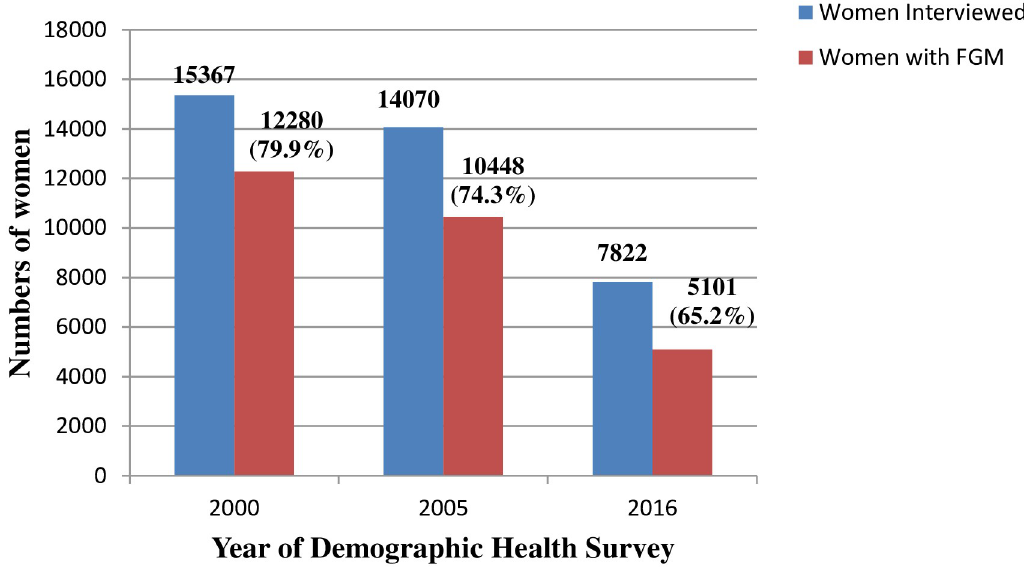
Fig 1. Women in Ethiopia who were interviewed and who reported female genital mutilation (FGM) in 2000, 2005 and 2016.